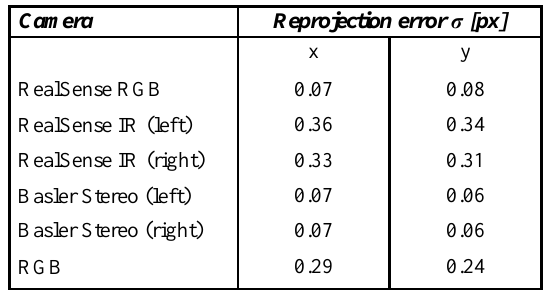
Table 4. Reprojection error standard deviations for the tie points used for intrinsic camera calibration.